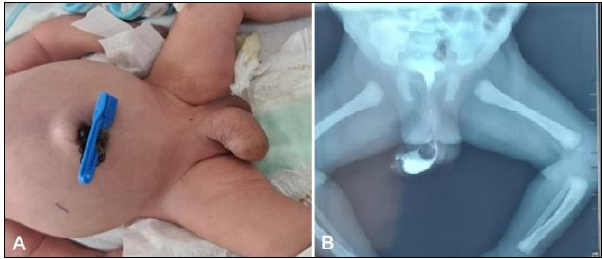
Figure 1: A) Abdominal distension and swelling of the anterior ventral shaft of the penis. B) Retrograde cystourethrogram showed scaphoid dilatation of the ventral aspect of the anterior and mid penile